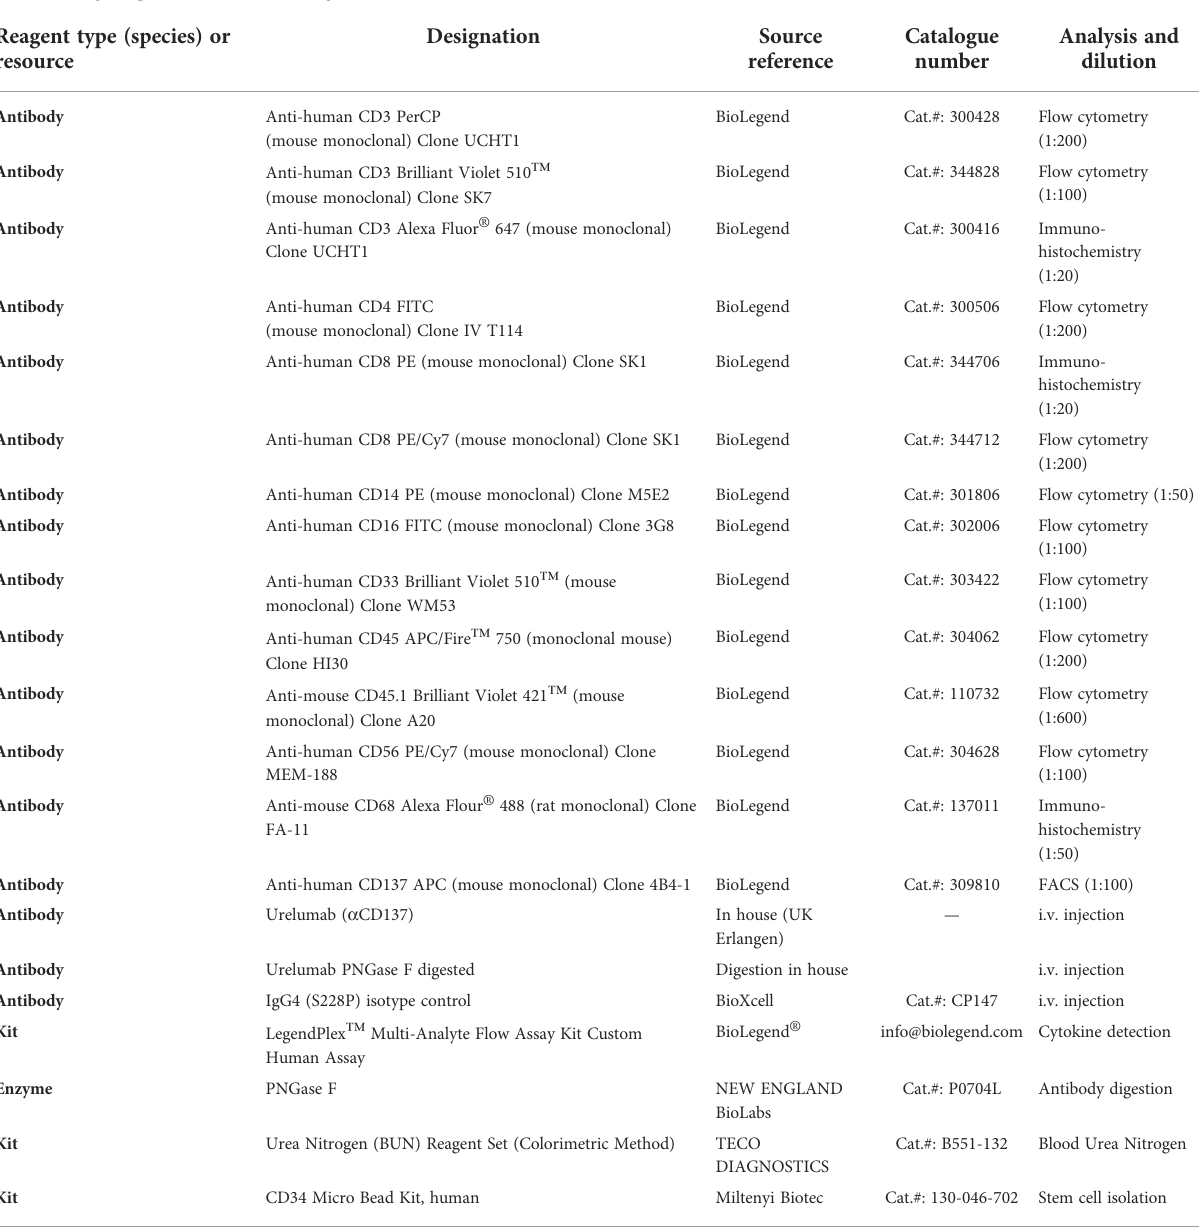
TABLE 1 Key reagents used for the study. Reagent type (species) or